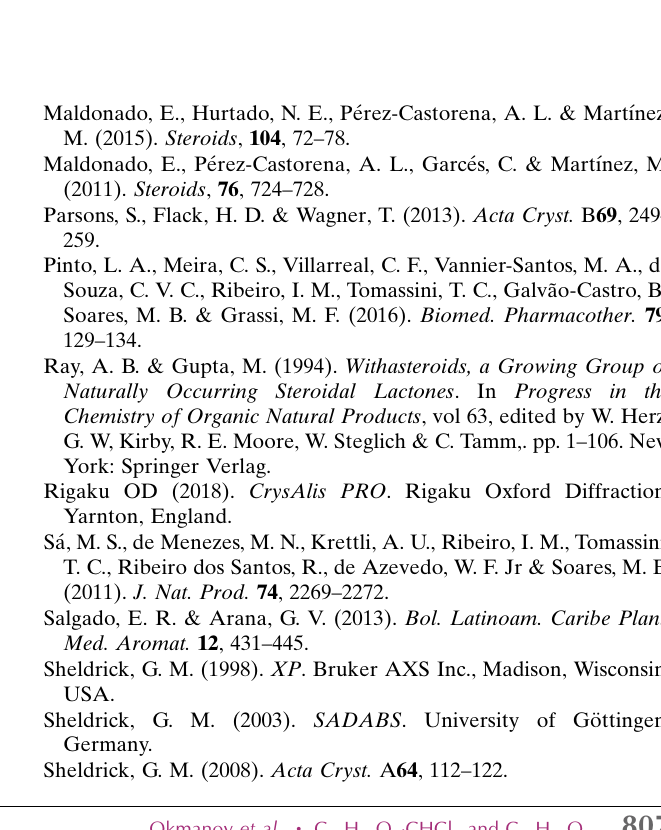
Crystal data Chemical